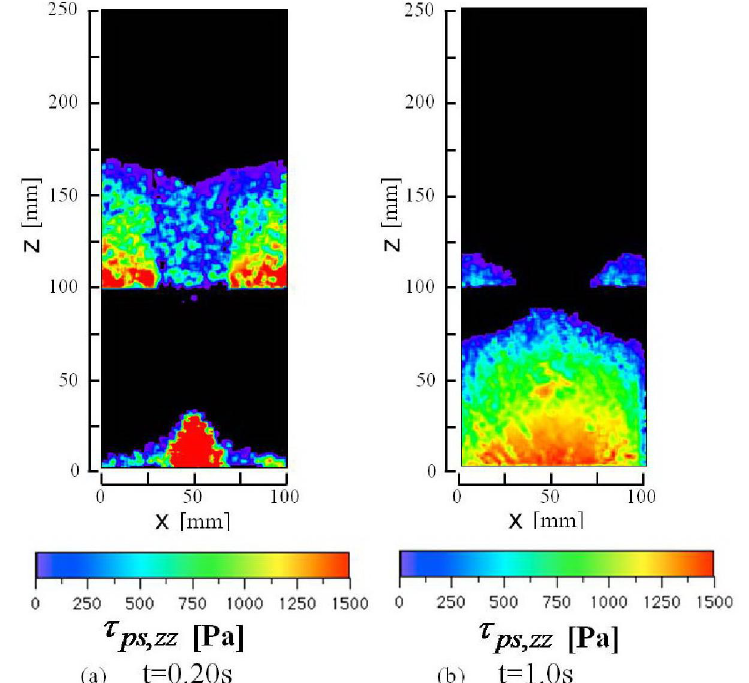
Figure 9. Calculated iso-contour of vertical normal stress (strain rate independent stress), τ in the presence of air in the center cross-section of the computational domain ps,zz is a calculated value averaged in an air computational y = 2.5 mm. The stress τ ps,zz